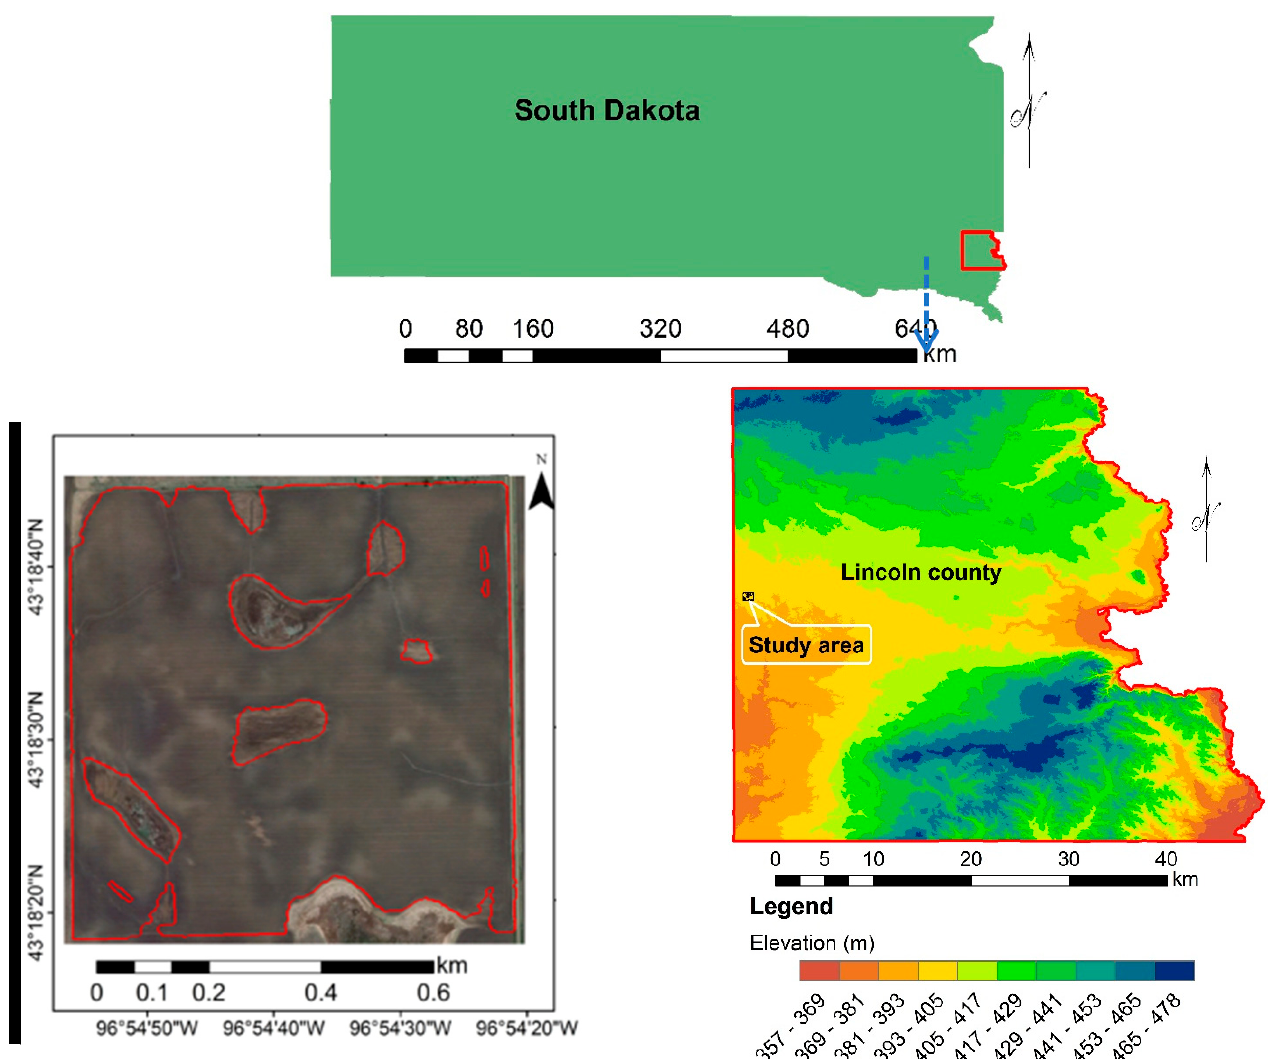
Figure 1. Location of study area in the United States